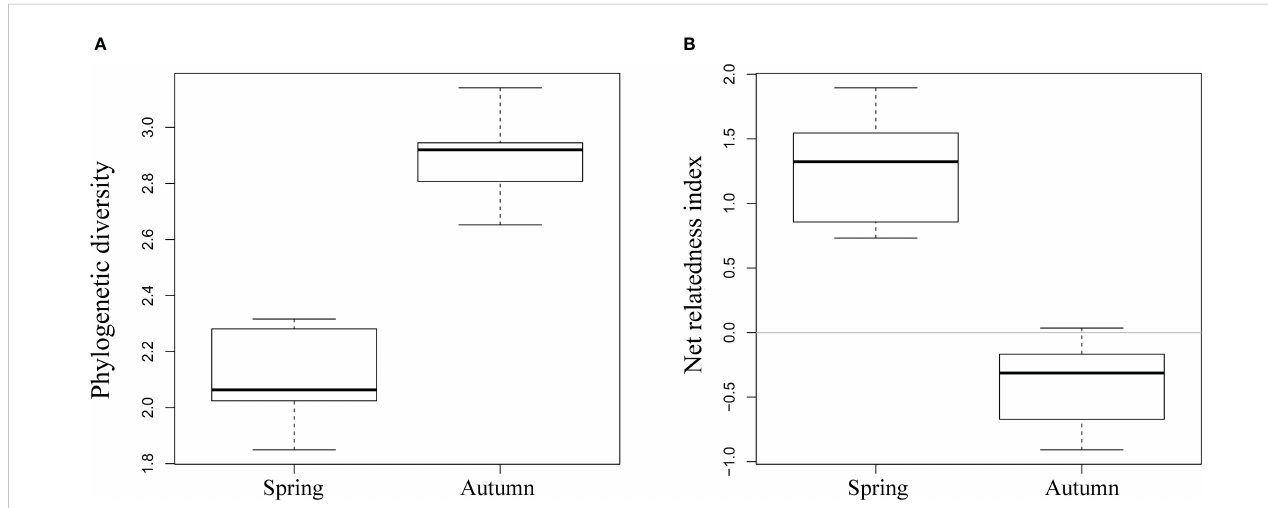
FIGURE 4 Variance analysis with permutation tests for values of phylogenetic diversity (A) and net relatedness index (B) in nektonic communities of Weizhou Island in spring and autumn.